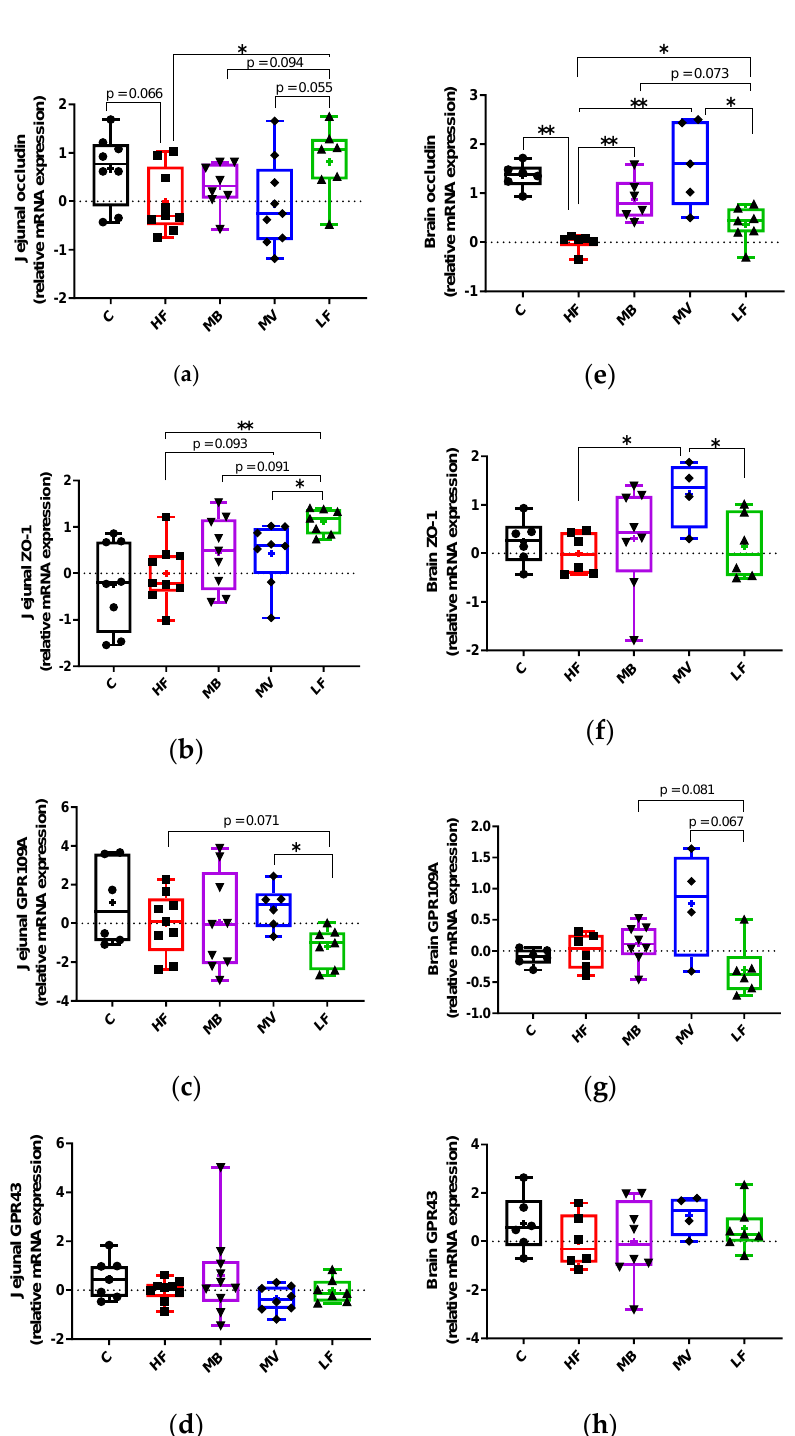
Figure 2. Gene expression of tight junction proteins (zonula occludens (ZO)-1 and occludin) and short-chain fatty acid receptors (G-protein-coupled receptor 43 / GPR43 and GPR109A) in the jejunal ( a – d ) and brain ( e – h ) tissues of conventional rats fed a pure high-fat diet (C), or Apolipoprotein E-knockout (ApoE- / -) rats fed a low-fat diet (LF) or high-fat diet (HF), pure or supplemented with 1% monobutyrin (MB) or monovalerin (MV) for 5 weeks ( n = 8–10 / group). Rats from the C, HF, MB, MV and LF groups are shown as • , (cid:4) , (cid:72) , (cid:7) and (cid:78) , respectively. Box and whisker plots with error bars indicate minimum and maximum values, while central lines represent median and means shown as “ + ”. * p < 0.05, ** p <